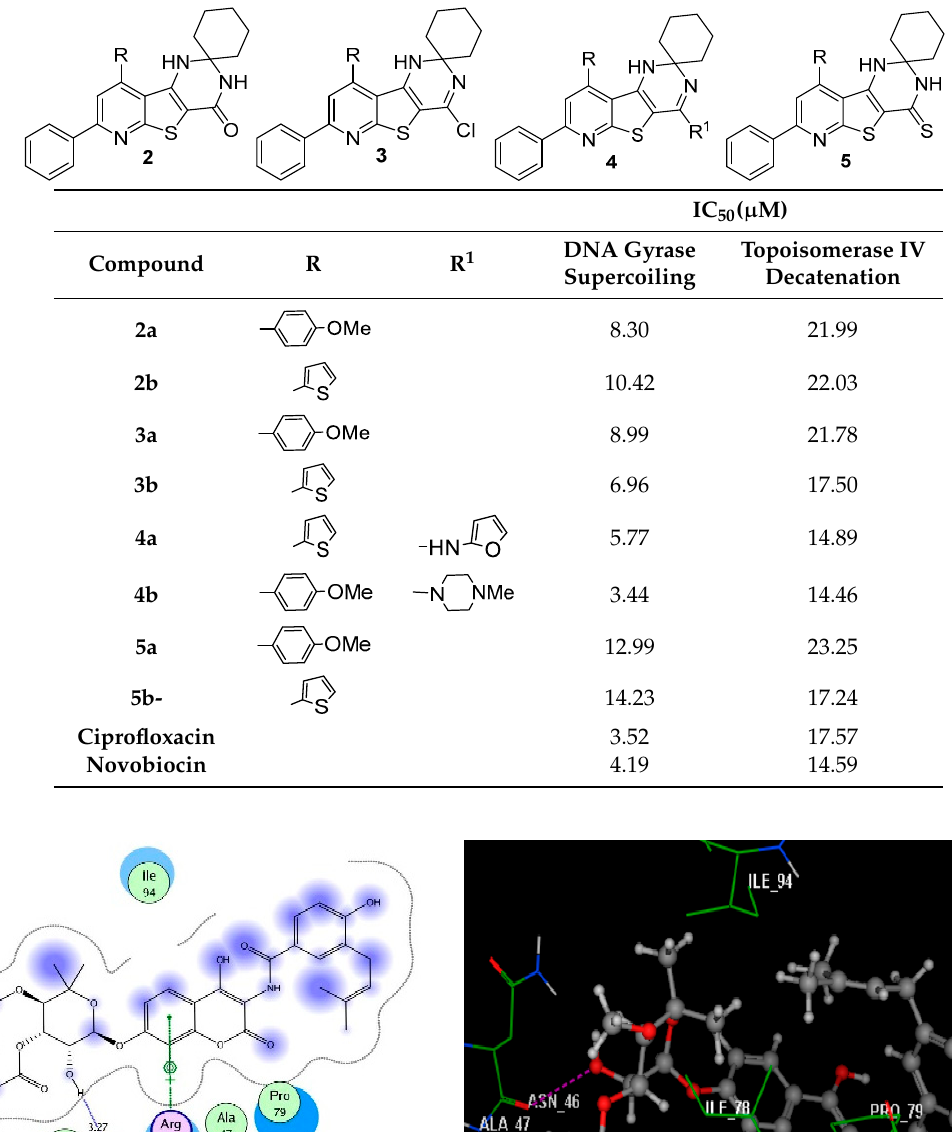
Table 2. Inhibitory activity of some selected compounds against E. coli DNA gyrase and topoisomerase IV enzymes.